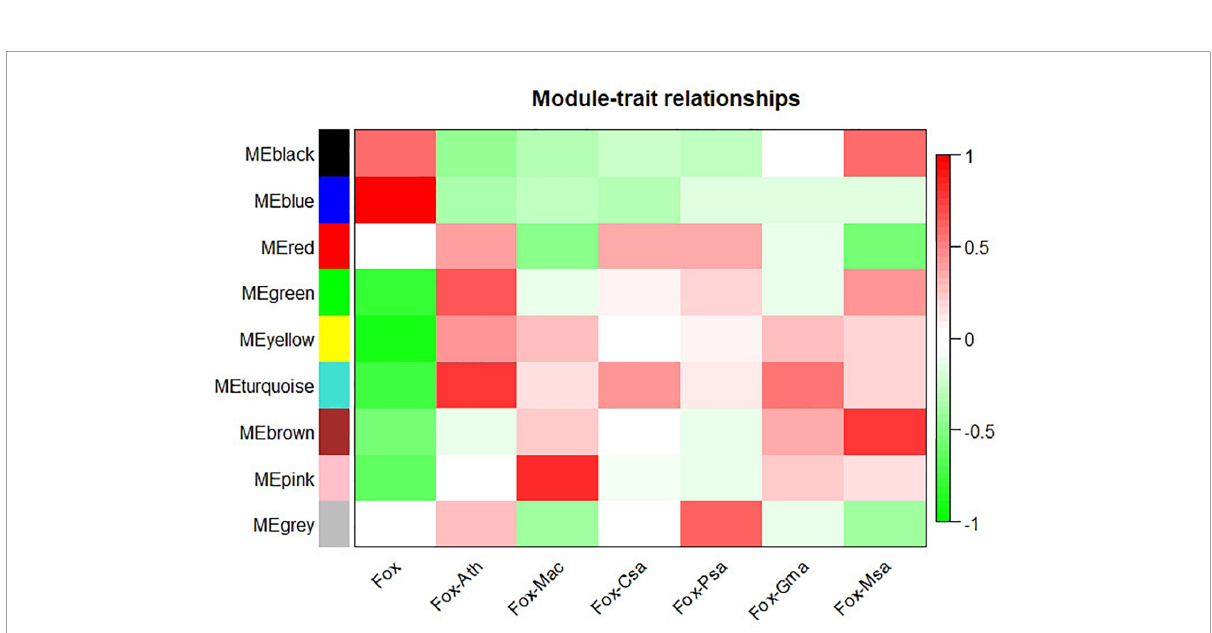
FIGURE5 Module-sample relationships. Each row corresponds to a different module shown on the left side, and each column represents a sample. Red represents high expression, and blue represents low expression. Fox, Fox-Ath, Fox-Csa, Fox-Gma, Fox-Mac, Fox-Msa, and Fox-Psa represent F. oxysporum in vitro culture, and F. oxysporum infection of Arabidopsis thaliana , Cucumis sativus , Glycine max , Musa acuminata , Medicago sativa , and Pisum sativum ,